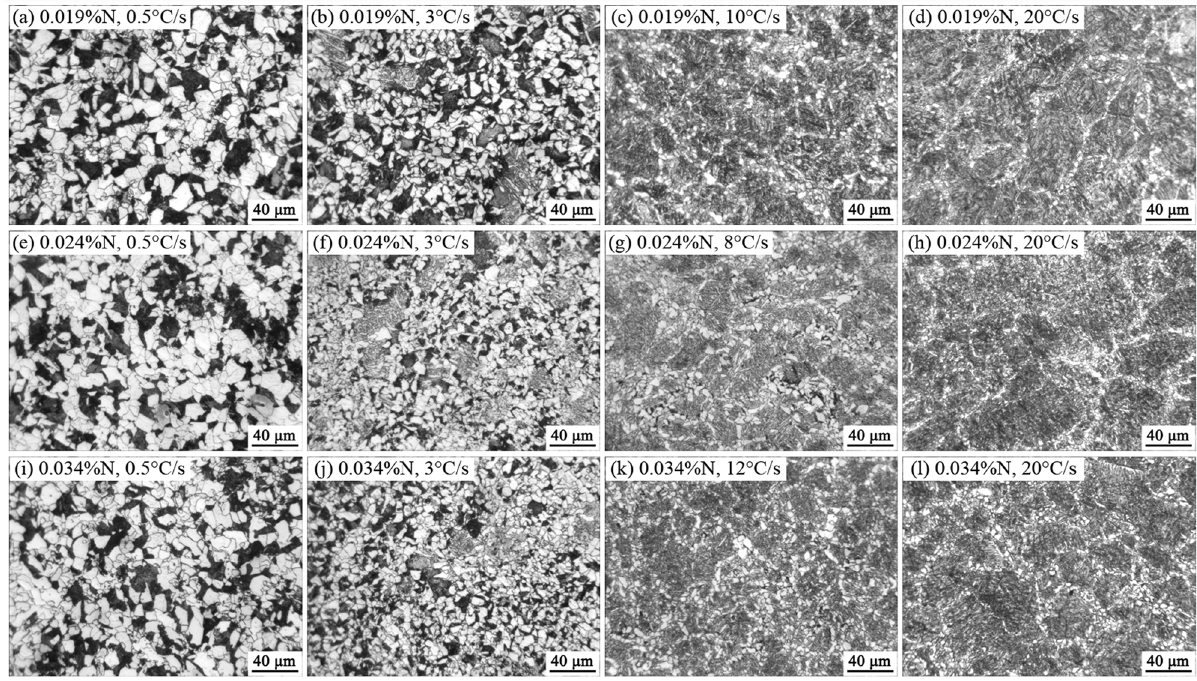
Figure 3: The microstructures of experimental steels obtained in the dilatometry specimens observed by optical microscopy: (a) – (d) VN1; (e) – (h) VN2; (i) – (l)